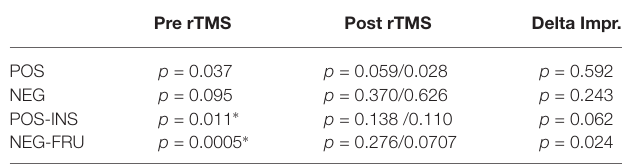
TABLE 2 | Affective Go/No-Go task (AGN) task performance in HC and BPD groups.